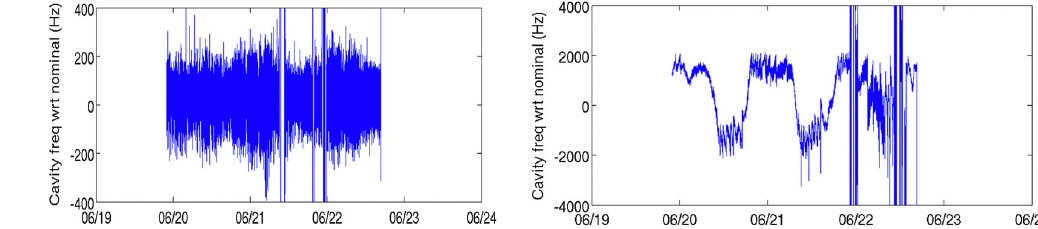
FIG. 4. Gun (left) and buncher (right) cavity detuning versus time (in days) when operating at nominal power and frequency with the frequency feedback on.